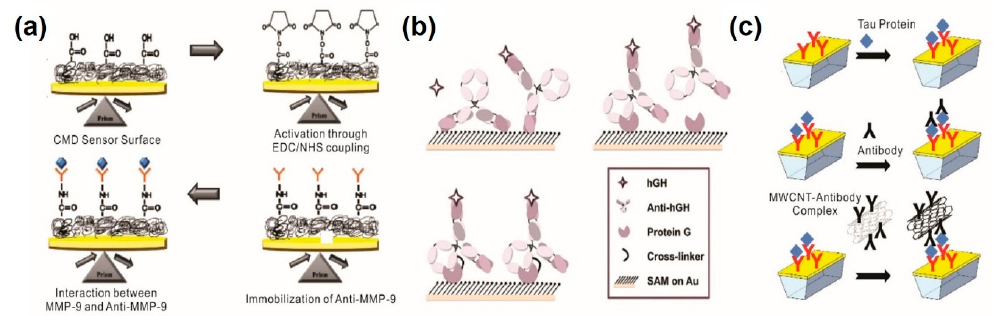
Figure 1. Propagating surface plasmon resonance (PSPR)-based immunosensors for protein biomarker detection. ( a ) Detection of human matrix metalloproteinases-9 by SPR-based immunosensor; ( b ) signal enhancement of SPR-based immunosensor by protein G meditated site direct immobilization of antibody; ( c ) signal amplification of SPR-based immunosensor by utilizing multi-walled carbon nanotubes as a mass enhancer. ( a ) Figure reproduced with permission from [28], © 2016 Elsevier; ( b ) Figure reproduced with permission from [29], © 2015 RSC Publishing; ( c ) Figure reproduced with permission from [30], © 2017